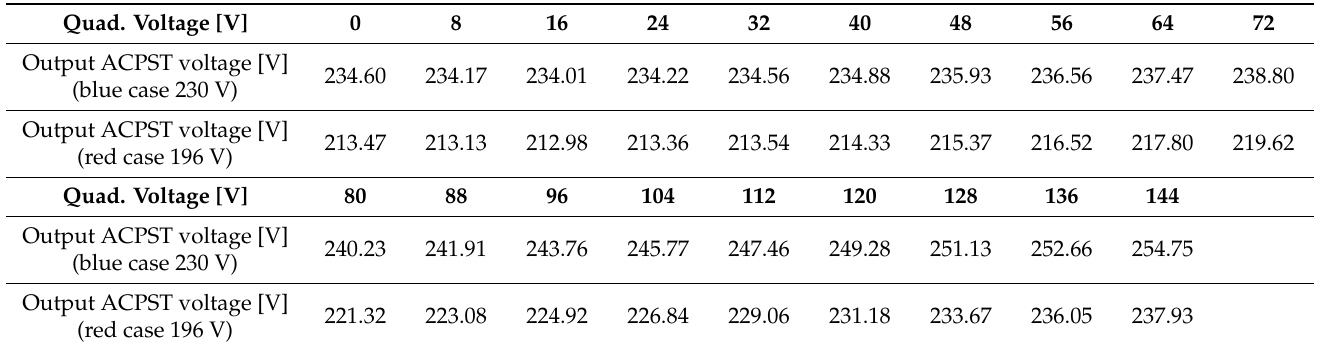
Table 3. The ACPST output voltages for 230 V and 196 V longitudinal voltages.